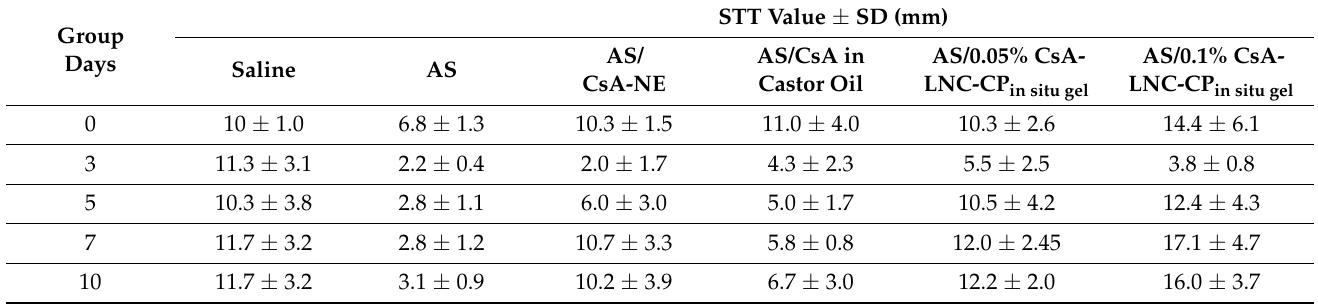
Table 2. Schirmer tear test values of rabbits receiving 0.9% saline only for 10 days (negative control), or 1% AS for 10 days and either not treated (positive control) or treated starting on day 4 with CsA-NE (0.05%), CsA in castor oil (0.05%), or CsA-LNC-CP in situ gel (0.05 and